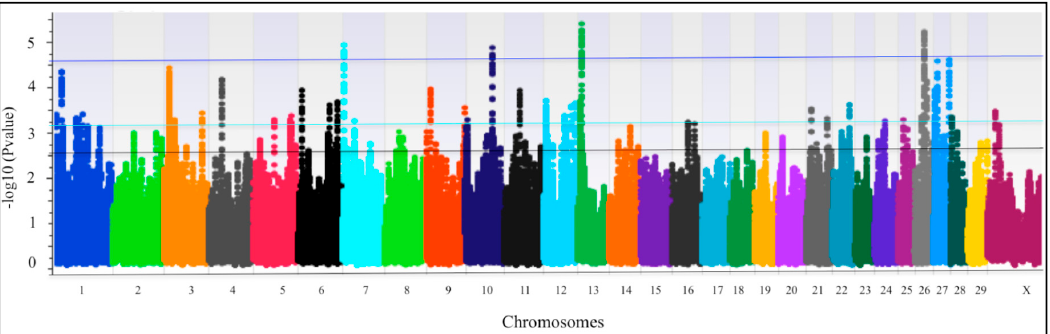
Figure 2. Manhattan plots of QTLR (Quantitative Trait Loci Regions) for all chromosomes. Horizontal lines represent the 1% PFP (proportion of false positives) (blue), the 5% PFP (light blue), and the 10% PFP (black) thresholds.